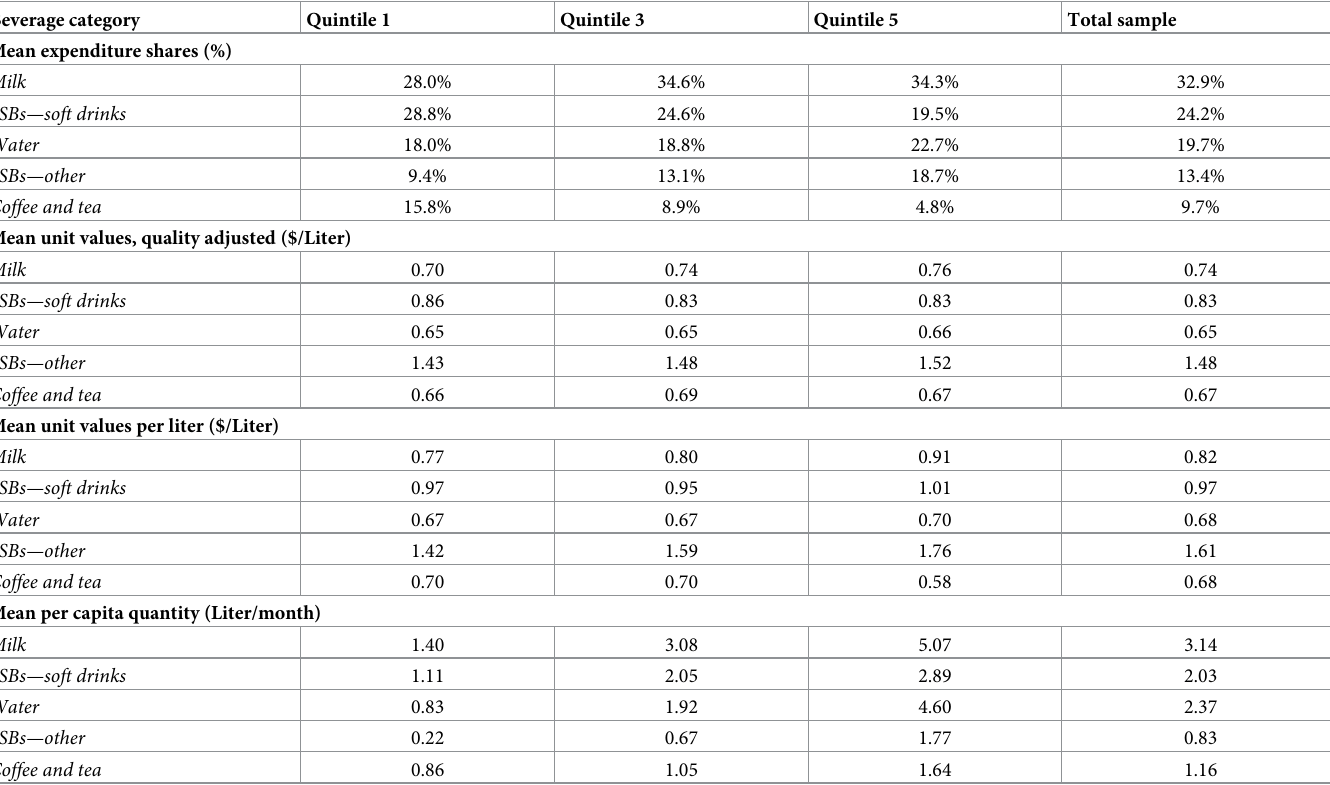
Table 2. Expenditure and consumption descriptive statistics: Whole sample and income